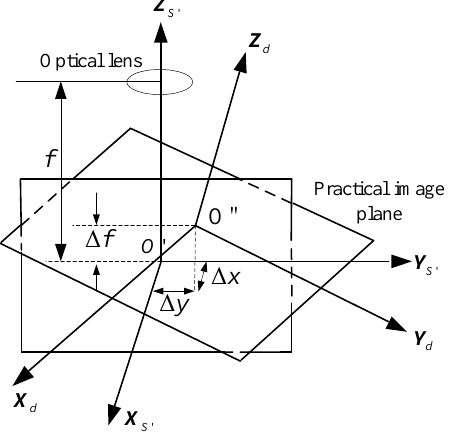
Figure 2. The schematic diagram of the image plane displacement error.